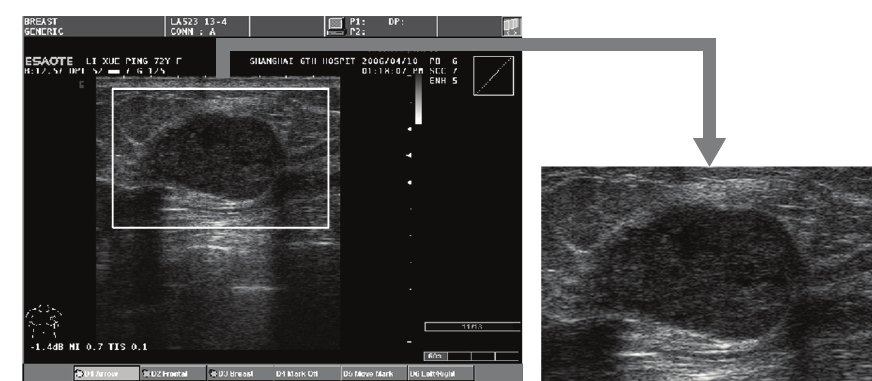
Figure 5: On the left is an US image captured from the sonographic scanner having a malignant tumor. On the right is the ROI